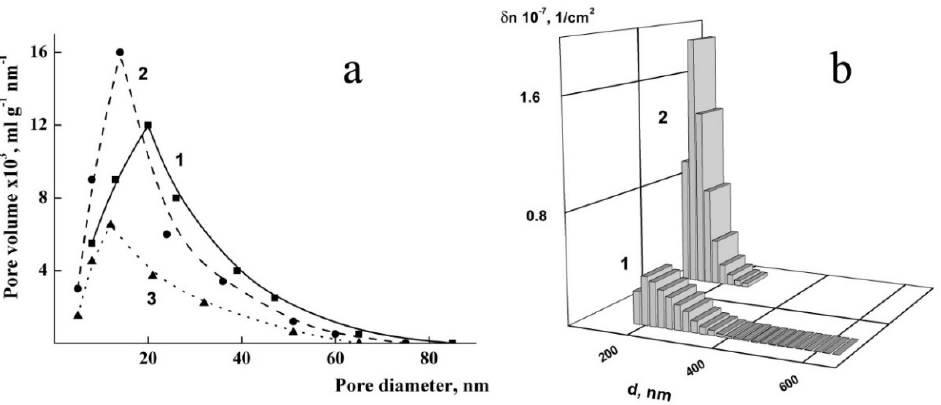
Figure 2. Pore sizes distribution in the samples (sorptometry): PE (1), PP (2) and PVDF (3) ( a ), through pore size distribution (filtration porosimetry): PE (1), PP (2) ( b ).